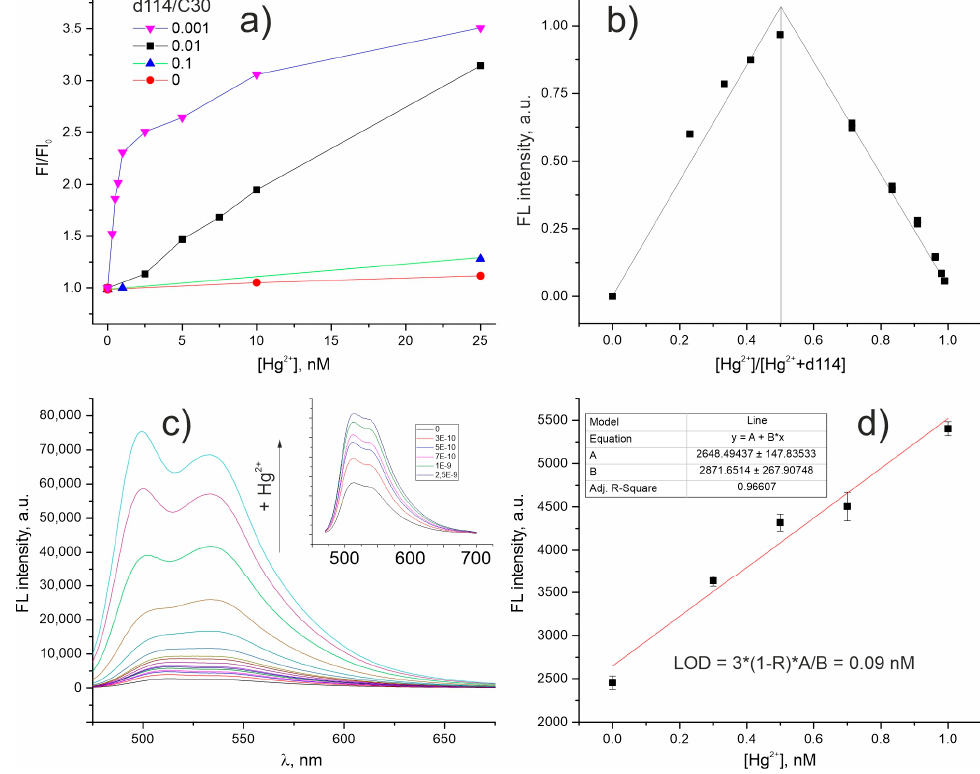
Figure 4. Characterization of d114/C30/F12 NPs in aqueous solution (pH = 6): dependence of luminescence intensity change (F/F 0 ) on Hg 2+ concentration for NPs with different d114 content ( a ); Job’s plots showing 1:1 interaction stoichiometry of d114 and Hg 2+ inside light-harvesting NPs d114/C30/F12 0.001/1/2 ( b ); the change in the luminescence spectrum of d114/C30/F12 0.001/1/2 so- lution upon the addition of Hg 2+ (the inset shows the spectra in Hg 2+ concentration range up to 2.5 nM) ( c ); dependence of the response signal on the analyte concentration in the range up to 1nM ( d ).